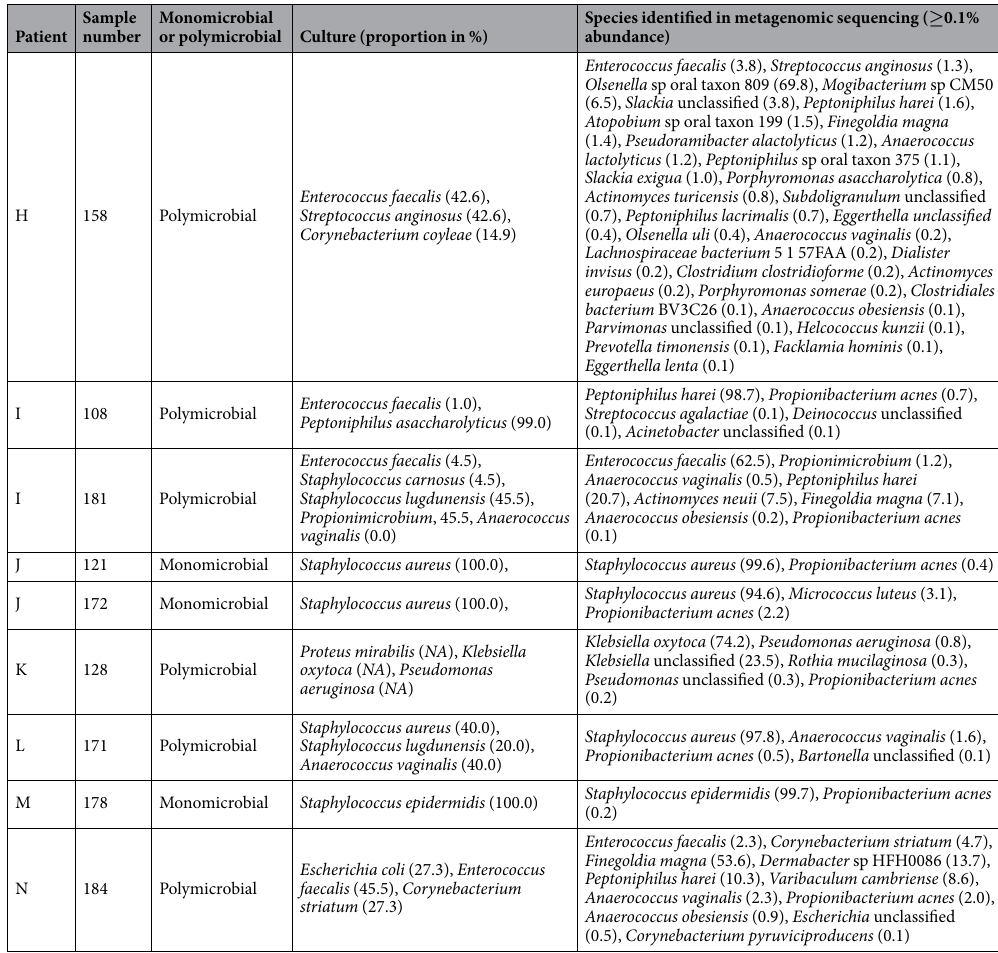
Table 2. Results of the culture and metagenomic sequencing of the 24 samples analysed in this study. NA: not found by MetaPhlAn2 at very high relative abundances (over 94.6%) with the exception of sample 46 in which Streptococcus anginosus was found at a relative abundance of 2.2% (Fig. 2). In polymicrobial samples (n = 16, Table 2), the sensitivity of metagenomic sequencing was 58.2% (32/55) at the species level. At the genus level, the sensitivity increased to 74.5% (41/55). Besides, metagenomic sequencing could identify all bacteria found by culture in a given sample in 11/24 (45.8%) samples at the species level, including 3/16 (18.8%) for polymicrobial infections. At the genus level, 15/24 (62.5%) samples were in agreement with cultures, including 7/16 (43.8%) samples with polymicrobial infections.